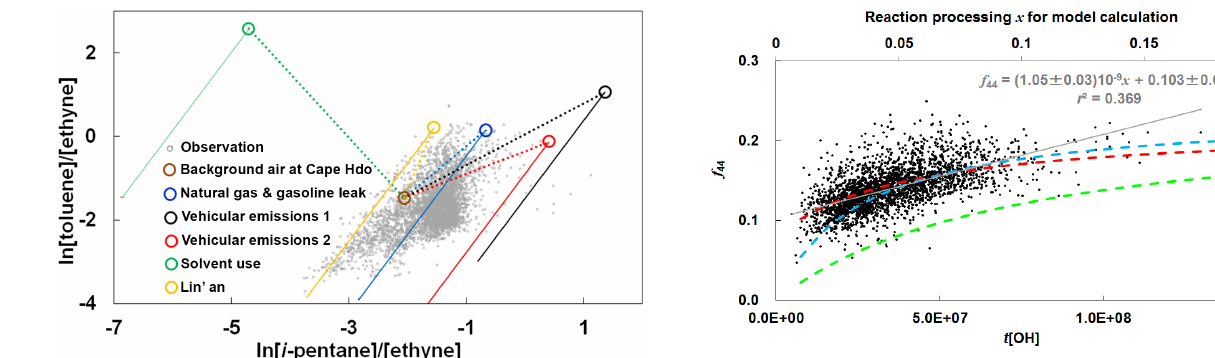
Figure 7. Scatter plot of natural logarithm of [toluene] / [ethyne] ratio as a function of natural logarithm of [ i -pentane] / [ethyne] ra- tio (gray dots). Linear regressions shown are calculated depletion trends resulting from mixing with background air (dotted lines) and from reaction with OH radicals (solid lines); these trends were de- termined by using the initial NMHC ratios from the literature, for vehicular emissions 1 (black open circle), vehicular emissions 2 (red open circle), solvent use (green open circle), and natural gas and gasoline leakage (blue open circle) observed in Beijing (Wang et al., 2015), as well as field measurement data obtained at Lin’an, a ru- ral background site in the Yangtze River Delta, China (yellow open circle), from Tang et al. (2009). The brown open circle that all the dotted lines meet at corresponds to the background values observed at Cape Hedo (Kato et al., 2004). See the text for the calculation and references for these data.